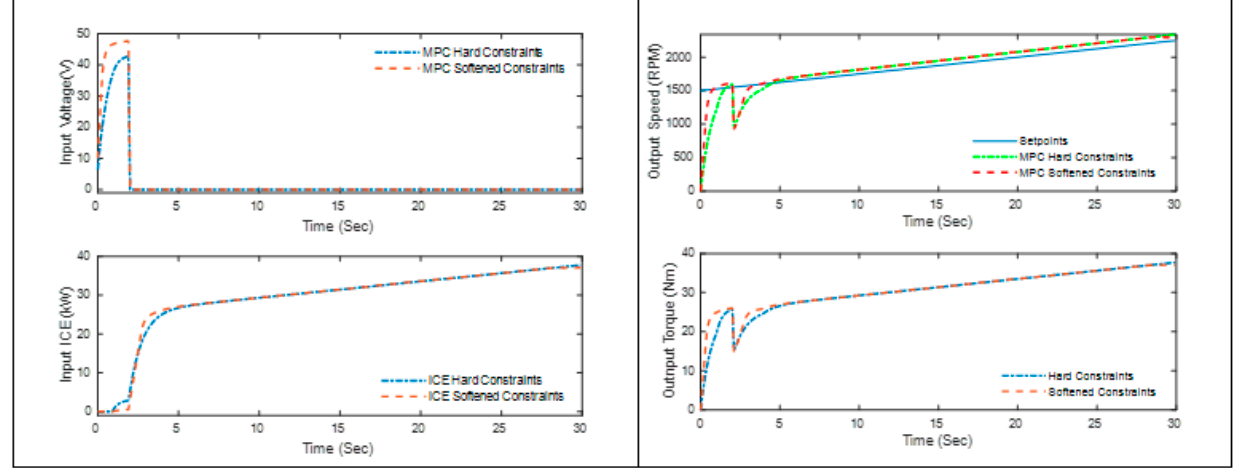
Figure 11. Comparison of two MPC performances.